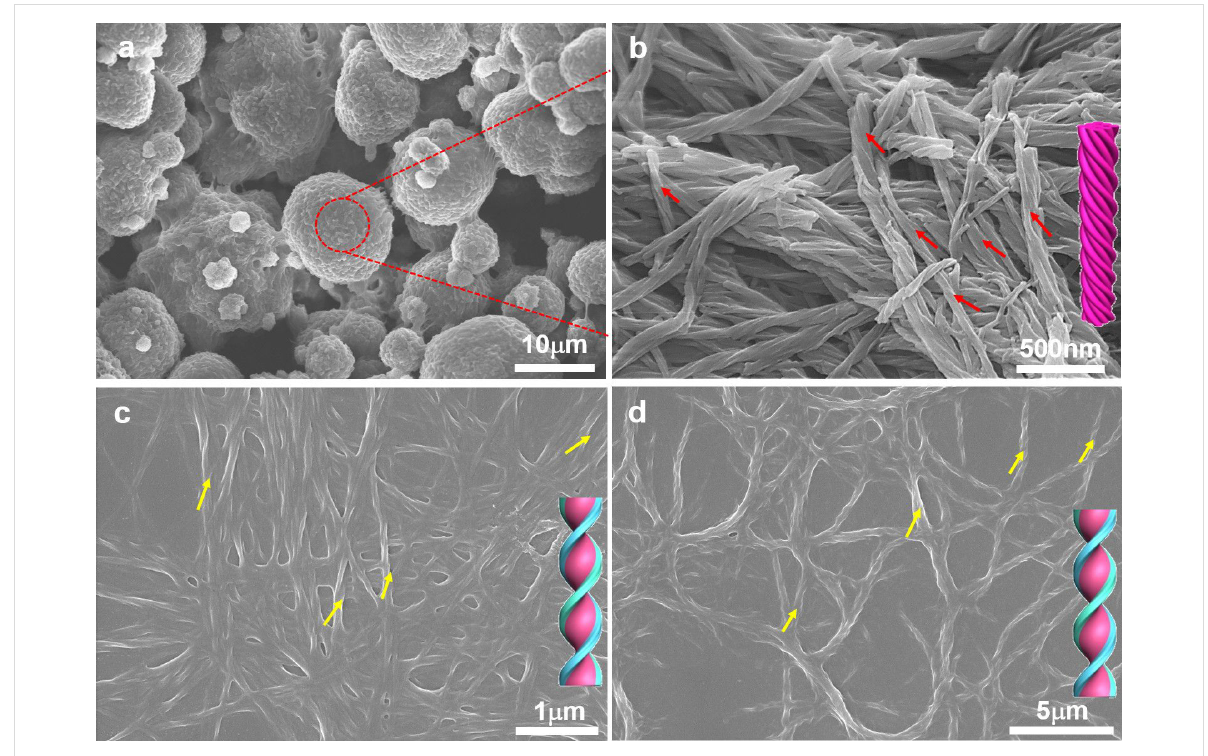
Figure 7: SEM images of the 3NCLG assembly in (a,b) MeOH, (c) DMF, and (d) THF. The concentration is 12 mg/mL.